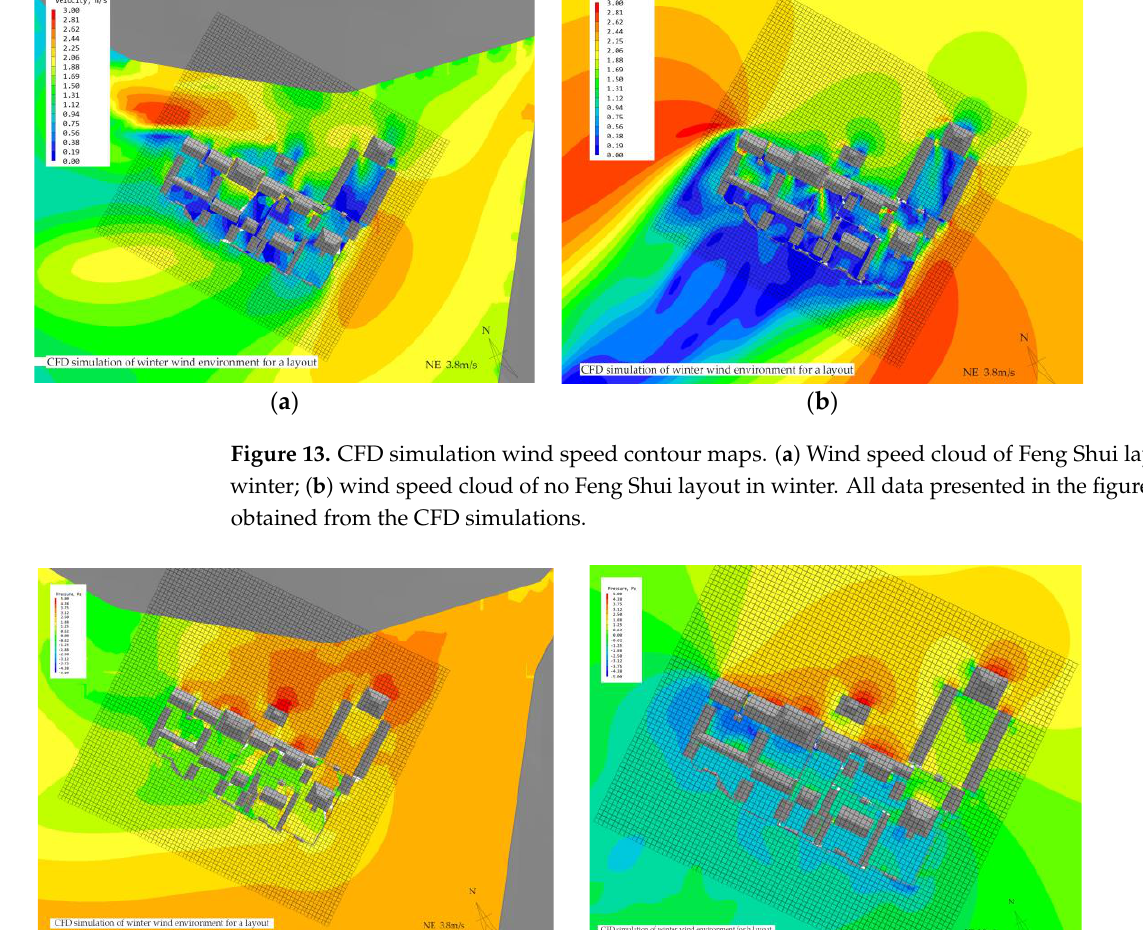
Figure 14. CFD simulation wind pressure contour maps. ( a ) Wind pressure cloud of Feng Shui layout in winter; ( b ) wind pressure cloud of no Feng Shui layout in winter. The figures were obtained by CFD simulation. All data presented in the figures were obtained from the CFD simulations.